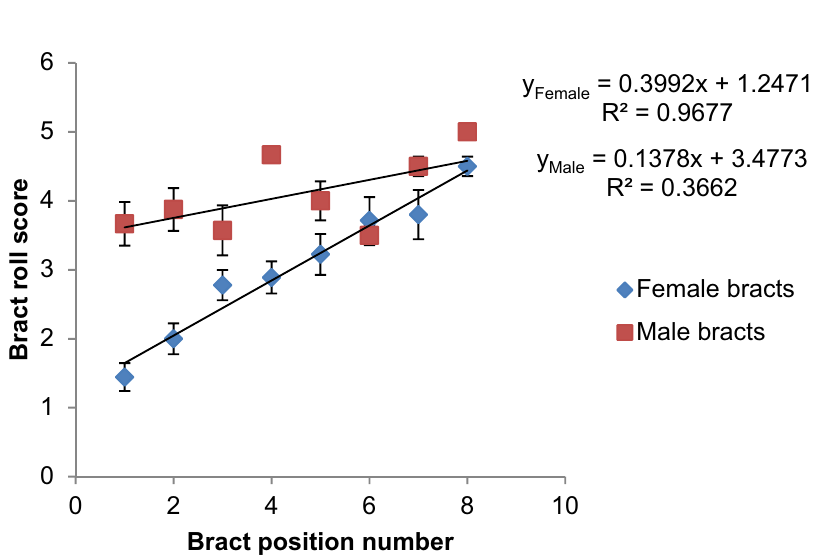
Figure 3. Average bract roll scores of bracts subtending female and male flowers for various inflorescences of selected banana genotypes. A score of 1 = minimal roll and score of 5 = full bract roll, error bars denote mean ± 10% standard deviation.